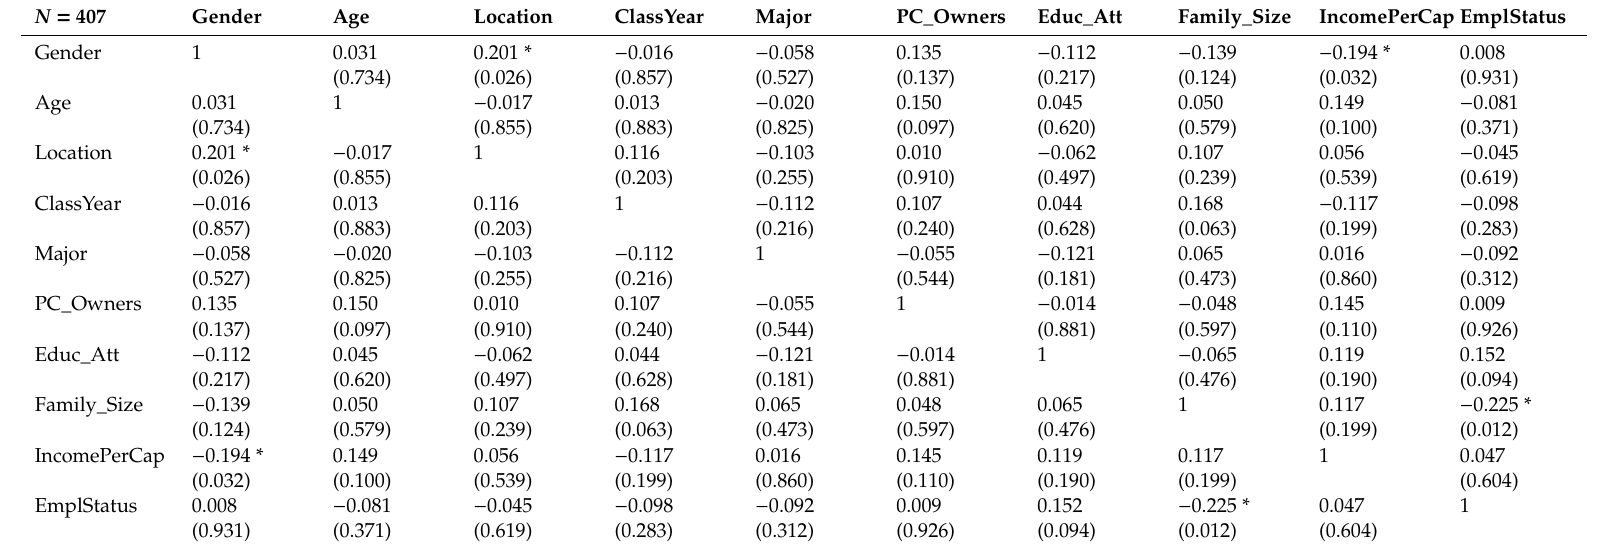
Table 4. Correlation between variables characteristics of Matrix M and W for the 2nd